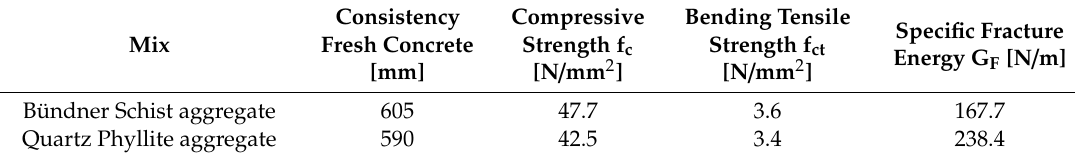
Table 4. Fresh and hardened concrete properties of concrete mix design from Table 3.